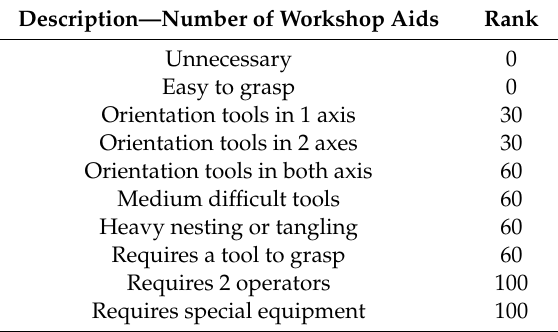
Table 3. Membership functions in tabular form of linguistic variables for “number of workshop aids”.